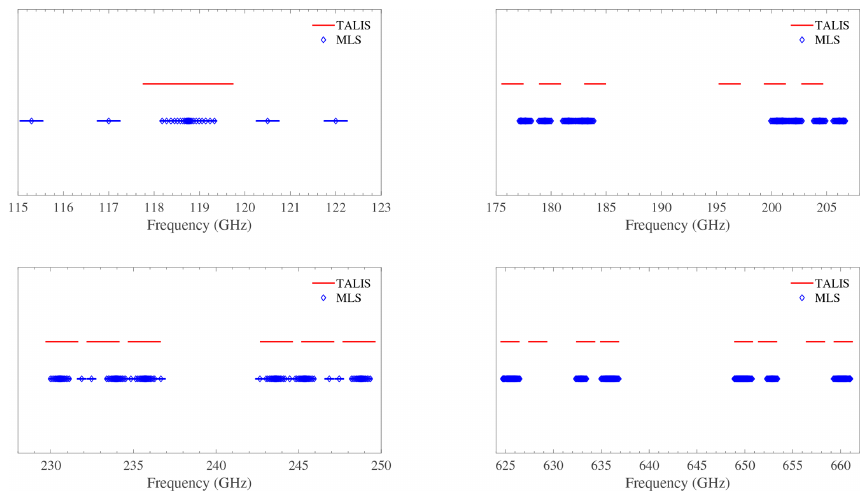
Figure 3. Spectral bands of the Aura MLS and TALIS radiometers. The diamonds represent the filter centres and the solid lines mean the bandwidth of the